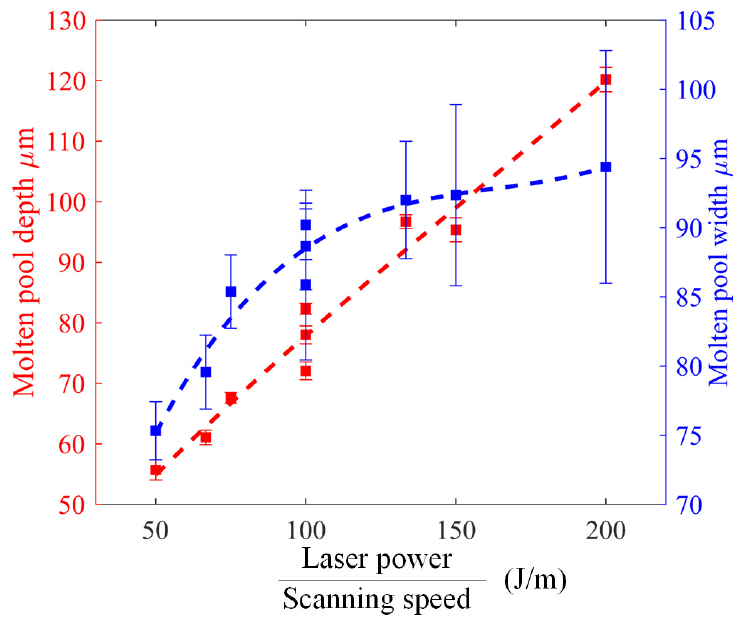
Figure 10. The dependences of the depth and width of the molten pool on the linear energy density of the laser power.